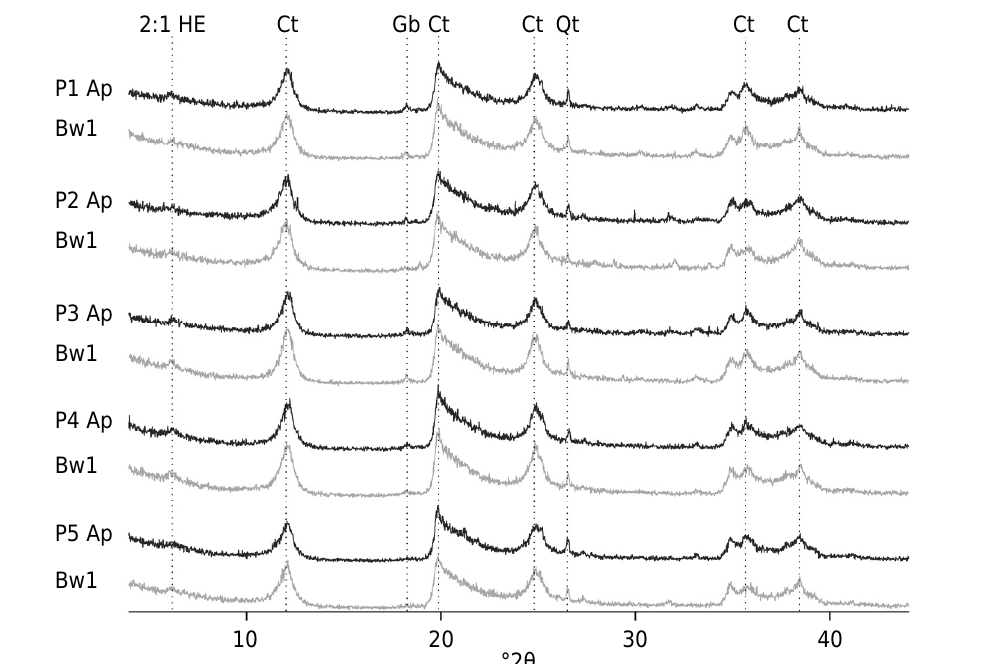
Figure 3. X ray diffractograms patterns of powder of iron-free samples, showing the variation in the position of reflections of kaolinite (Ct), gibbsite (Gb), quartz (Qt) and 2: 1 HE in the Ap and Bw1 horizons of the five profiles. P1: Haplic Ferralsol (Dystric, Clayic); P2: Haplic Ferralsol (Dystric, Clayic); P3: Rhodic Eutric Nitisol (Ochric); P4: Rhodic Ferralsol (Dystric, Clayic); P5: Rhodic Ferralsol (Eutric,